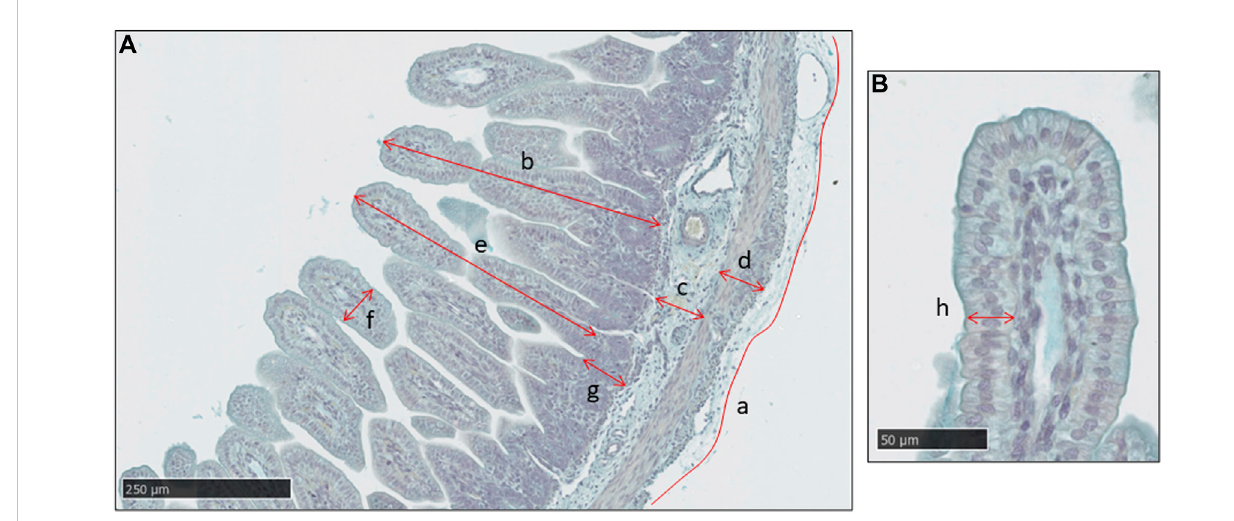
FIGURE 1 A typical histological image of the jejunum in a sheep fetus at 115 days of gestation, stained with Alcian Blue. (A) Measurements made of intestinal outer perimeter (a), thickness of the mucosa (b), sub-mucosa (c) and muscularis propria (d), villus height (e) and width (f) and crypt depth (g). Scale bar